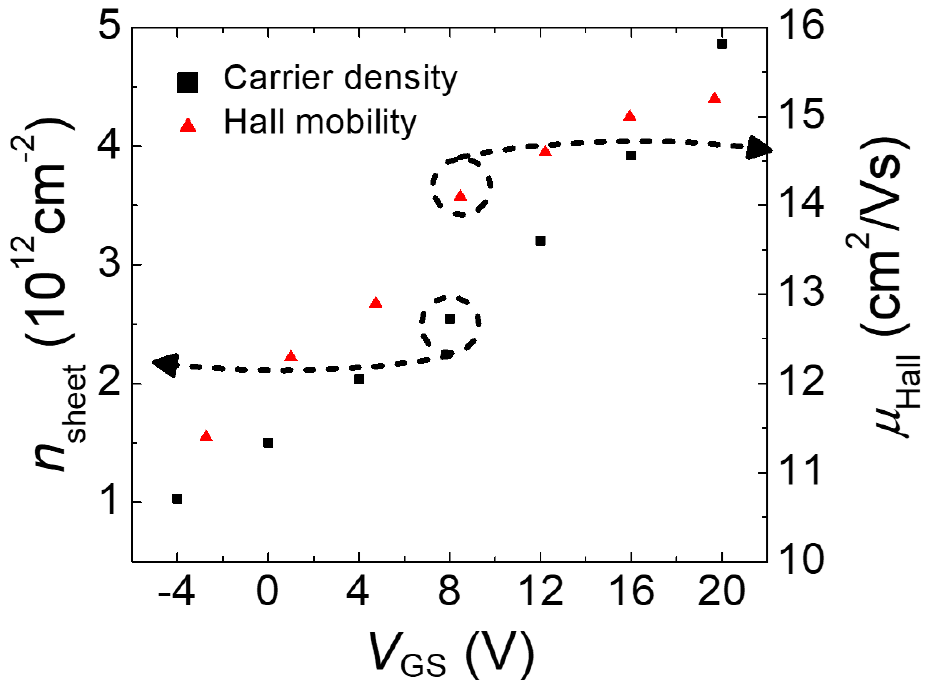
Figure 4. Electron density ( n sheet ) and Hall mobility ( µ Hall ) as a function of the gate voltage V GS .